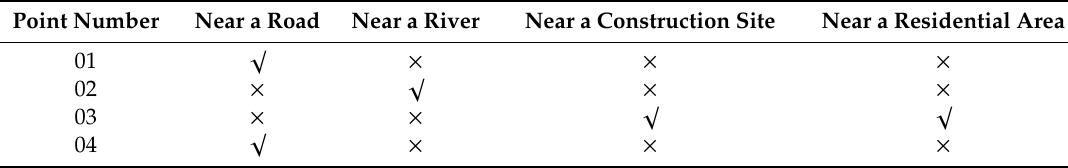
Table 3. Basic situation of monitoring